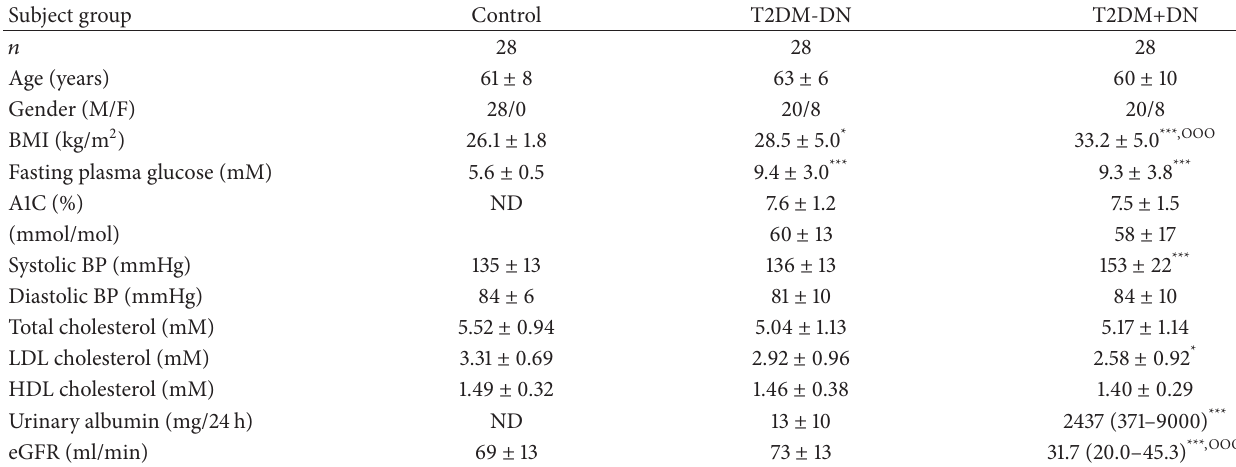
Table 1: Characteristics of human subjects recruited for this